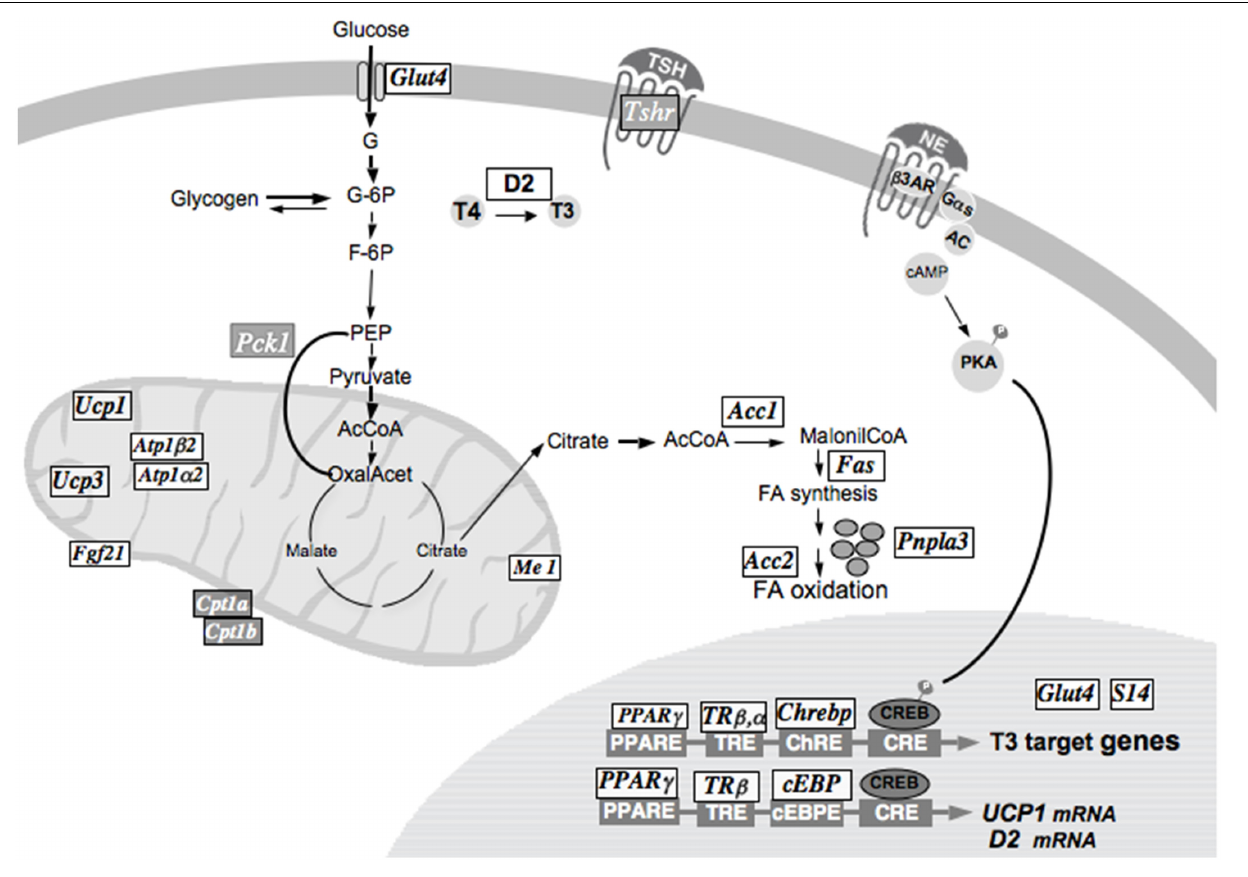
FIGURE 2 | T3 actions on gene expression in brown adipocytes are represented. The genes upregulated by T3 are shown in black with white background (UCP1, UCP3, Glut4, Me1, Spot14,